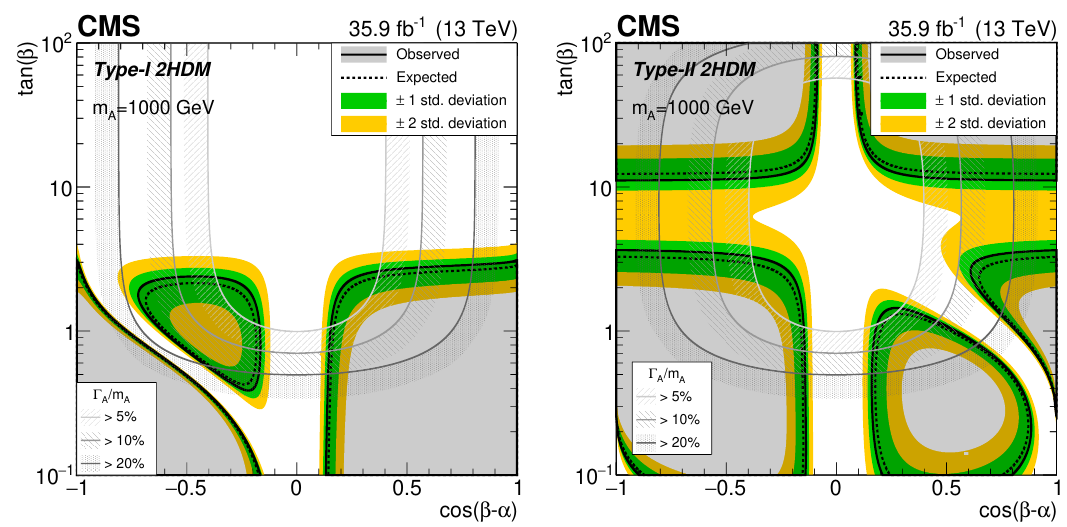
Figure 8 . Observed and expected 95% CL upper limit on (cid:27) (A) function of m A for the combination of the 0 ‘ and 2 ‘ channels. The inner green and outer yellow bands represent the 1 and 2 standard deviation (std.) variations on the expected limit. The solid (cid:6) (cid:6) line represent the exclusion for a spin-0 signal produced through gluon-gluon fusion, and dashed line represent the b quark associated production. The solid lines and their shaded areas represent the corresponding values predicted by the Type-I and Type-II 2HDM model (cid:12)xing the parameters cos( (cid:12) (cid:11) ) = 0 : 25 and tan (cid:12) = 1 parameters. In this scenario, the b quark associated production is (cid:0) negligible, and the A boson is predominantly produced through gluon-gluon fusion.